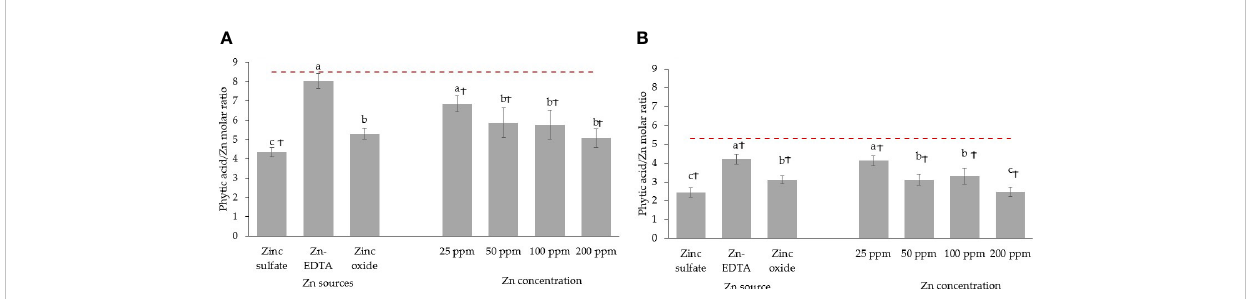
FIGURE 6 Seed soaking effect on phytic acid/Zn molar ratio in pea (A) and sun fl ower (B) microgreens. Vertical bars indicate average values and the standard error. Different letters indicate signi fi cant differences at p = 0.05 by the Fisher LSD test. The dashed line indicates the average value of the untreated control. Ϯ indicates a signi fi cant difference compared to the control using contrast in the linear mixed model.